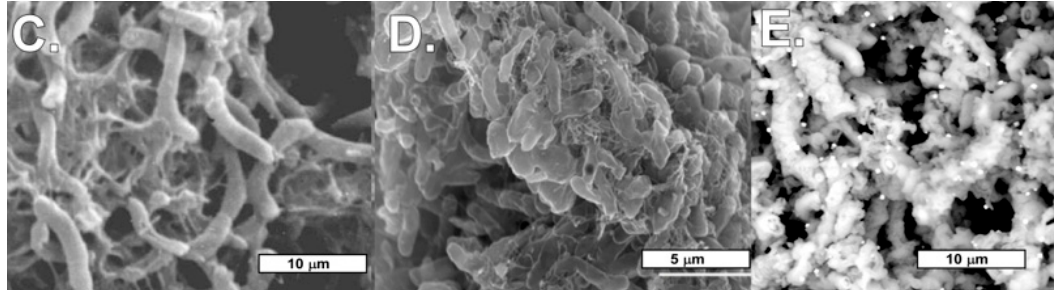
Figure 8. Similarities of known biofilms compared to the biofilms found within the middle layer of the black crusts, as viewed using SEM. ( A ) Staphylococcus aureus bacteria, part of the firmicutes phylum, easily identified by their ovoid shape and conjoined behavior, averaging two microns in diameter [22]. ( B ) Image of potential S. aureus bacteria biomat from the middle layer of gold coin black crust from the SS Central America shipwreck. ( C ) Biofilm (sulphate-reducing) grown under anaerobic conditions on the surface of mild carbon steel [21]. These bacteria are elongate, averaging ten microns in length, and arcuate, creating a dendritic colony form. ( D ) Heavily biomineralized filamentous bacteria colony ( C. metalidurans ) growing on the surface of a placer gold nugget [23]. ( E ) Probable mineralized biofilm from the middle layer of a gold coin black crust from the SS Central America shipwreck. Sub-micron nano-particulate gold (white dots) is present throughout these biofilms.